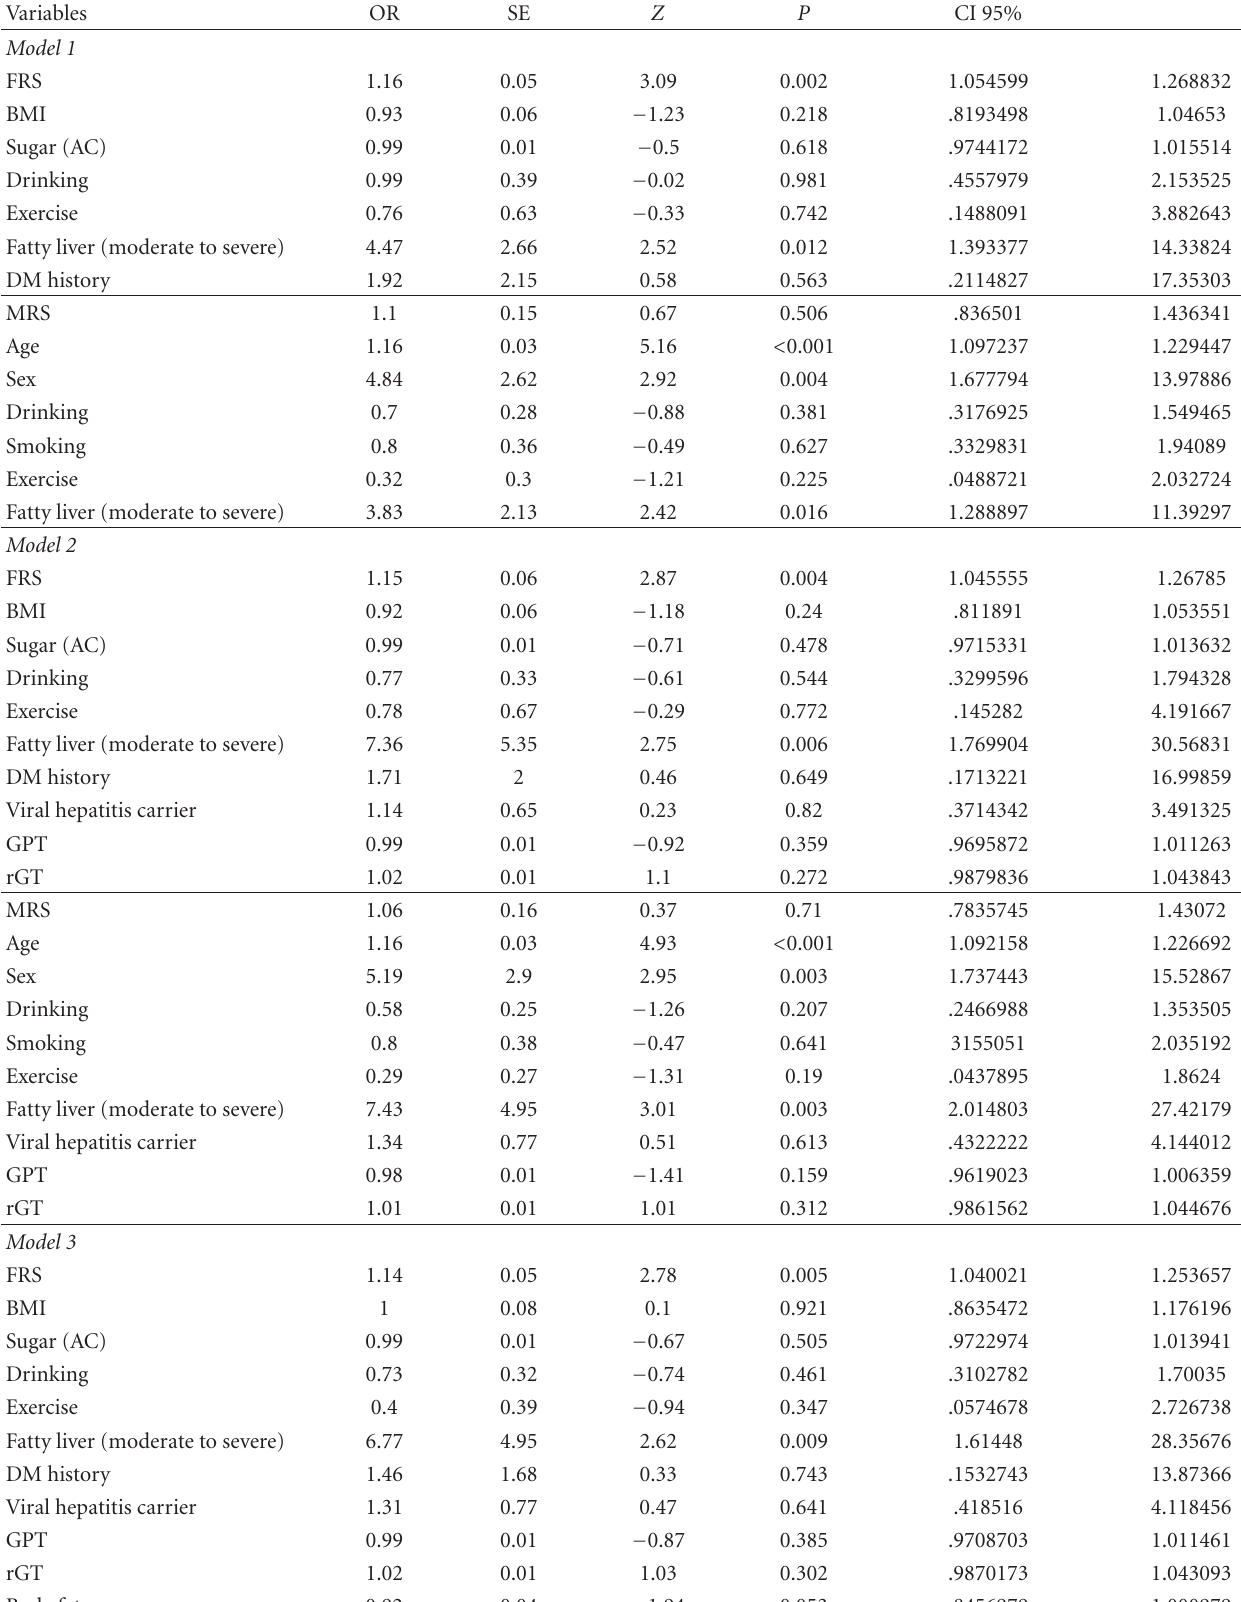
Table 2: Multivariate logistic regression models in predicting coronary calcium